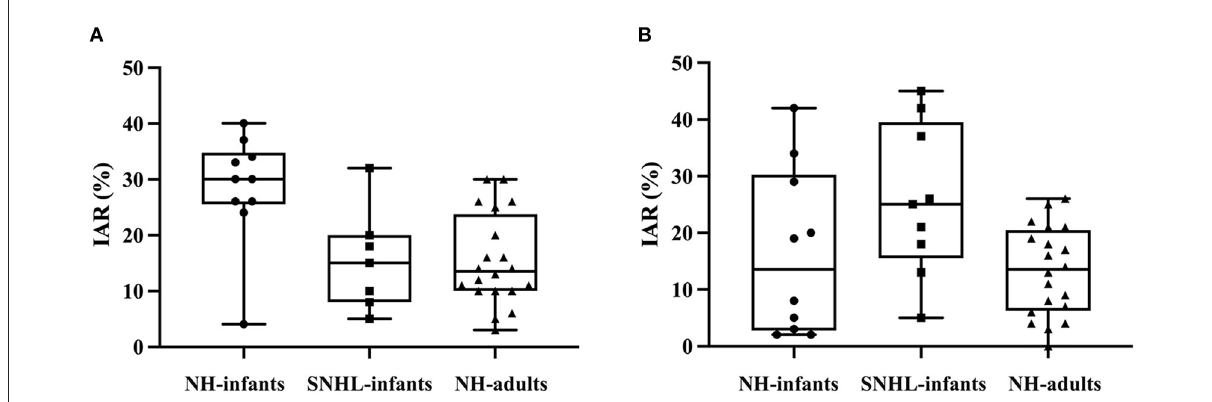
FIGURE6 The distribution of corrected IAR of ACS-cVEMP and BCV-cVEMP. (A) The distribution of corrected IAR of ACS-cVEMP. (B) The distribution of corrected IAR of BCV-cVEMP. A wider range occurred in normal hearing infants compared with adults in both ACS-cVEMP and BCV-cVEMP. The